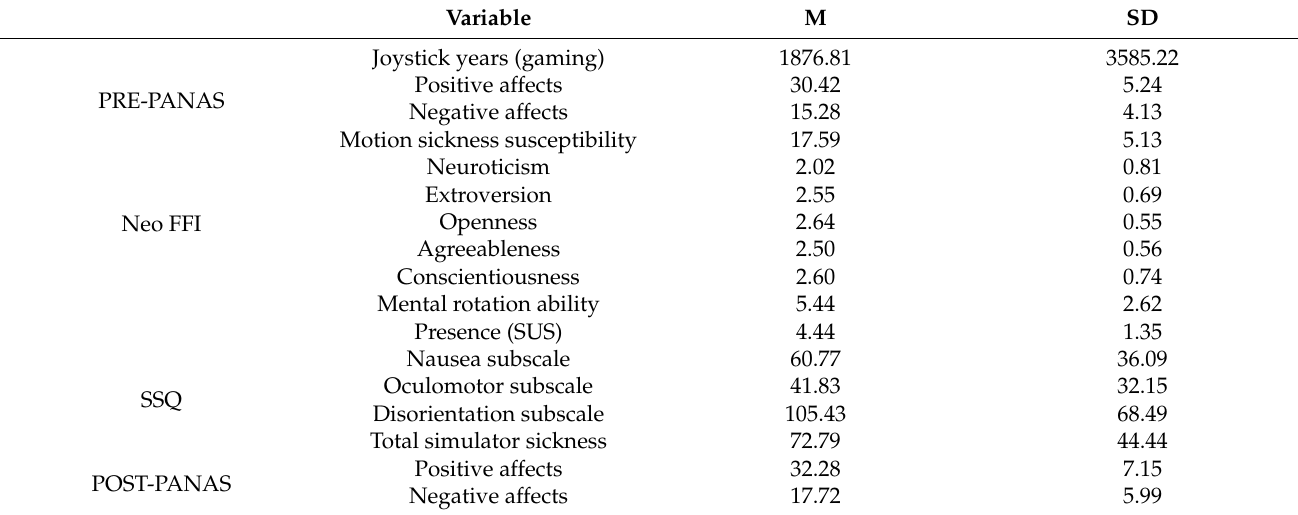
Table 1. The results for all the questionnaires used in the present study. Variable M SD Joystick years (gaming)